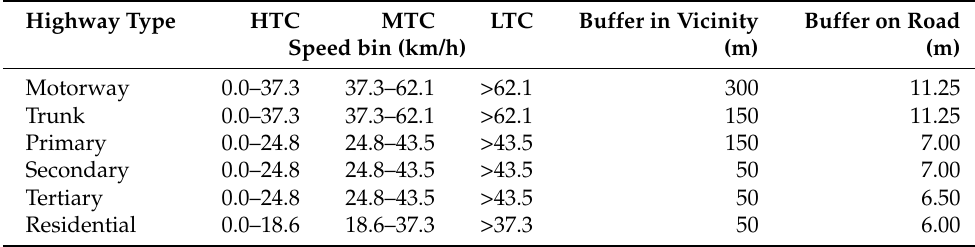
Table 4. OSM highway speed bins, along with road width measures and buffer sizes used for tweet filtering by the two proxies: User count within a vicinity and User count on a road segment . HTC: